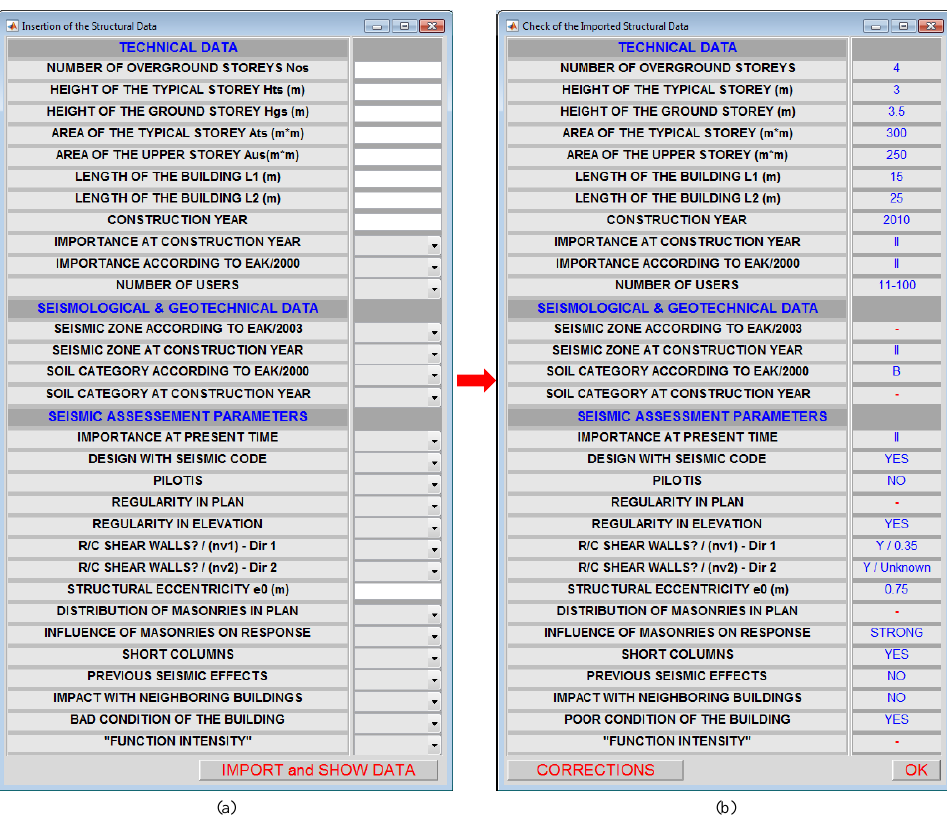
Figure 7. The windows used for the insertion ( a ) and checking ( b ) of the structural data.